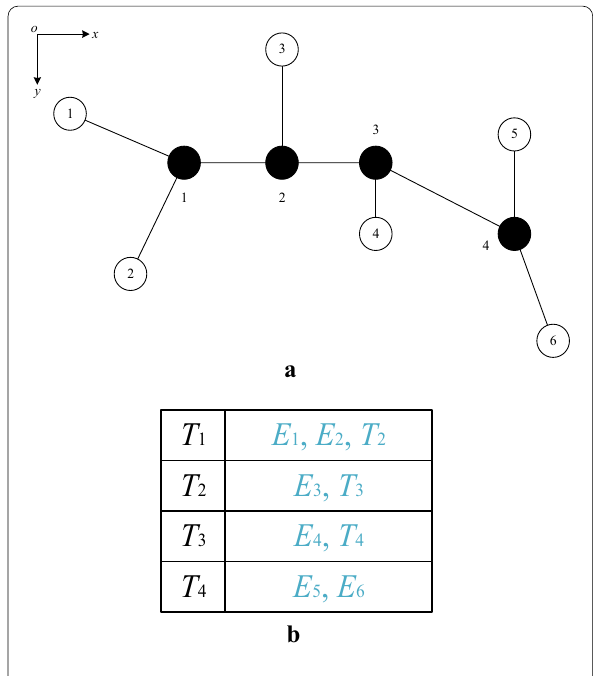
Figure 5 Encoding rules of the branch structure and the branch point: a The subscript serial numbers of the branch points and endpoints are ordered by the coordinate sequence; b The points in the adjacent list, i.e., the blue items, are used only